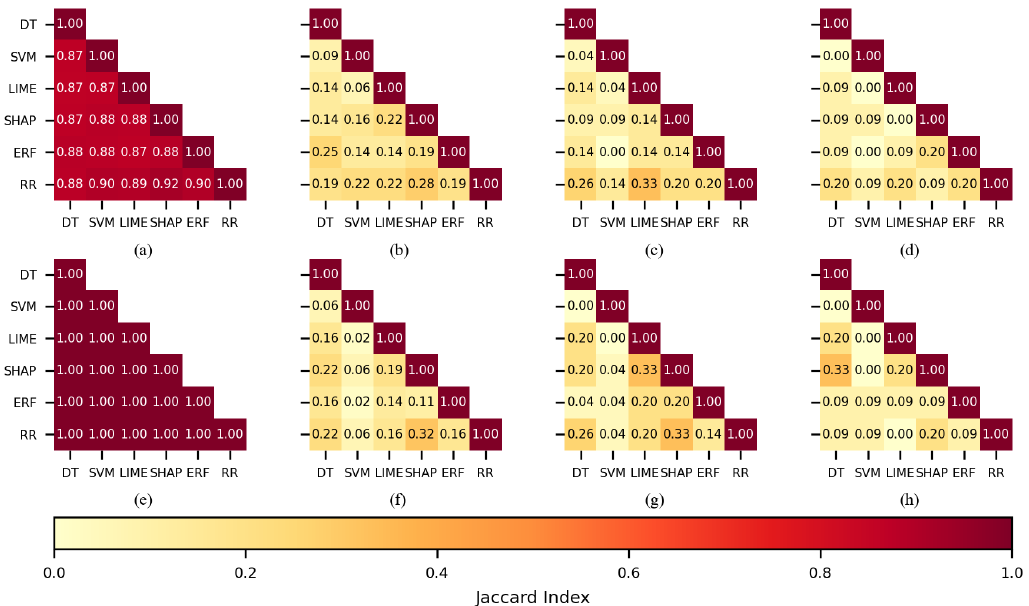
Figure 9. The similarity of the sets of features selected per each feature selection method when DT was used as a classifier. CHB-MIT dataset: ( a ) best 450 features, ( b ) best 150, ( c ) best 100, and ( d ) best 50. Siena dataset: ( e ) best 450 features, ( f ) best 150, ( g ) best 100, and ( h ) best 50.